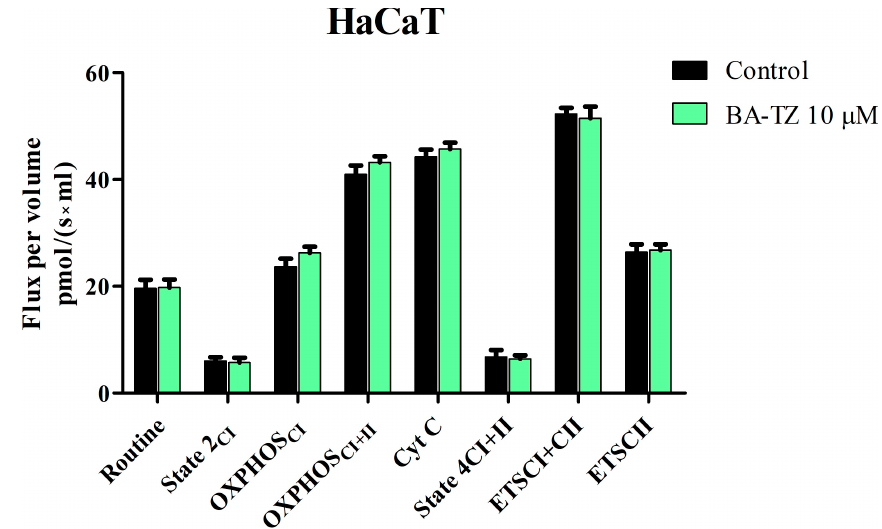
Figure 5. Mitochondrial respiratory rates of permeabilized HaCaT cells following 24 h treatment with BA-TZ 10 µ M. Data represent the mean ± SD of five individual experiments. The statistical differences vs. control was determined using one-way ANOVA analysis followed by Tukey’s multiple comparisons post-test. Values with p < 0.05 were considered to have a statistically significant difference ( p > 0.5 no significant differences).